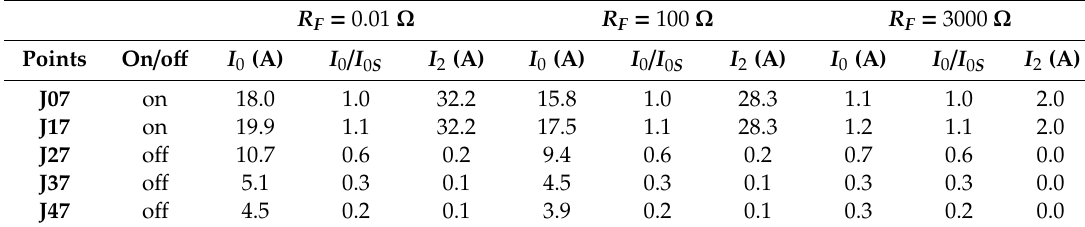
Table 2. Sequence currents at various point during earth fault 2.